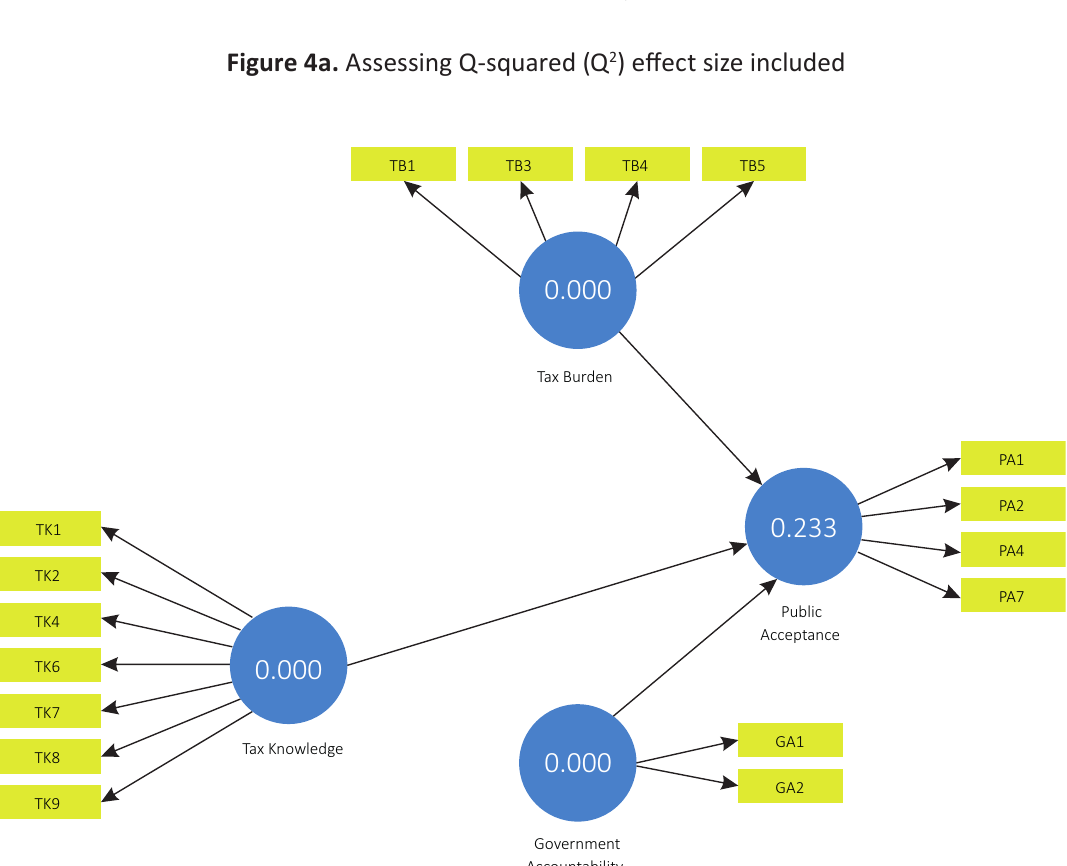
Figure 4b. Assessing Q-squared (Q 2 ) effect size Тax fairness excluded (blindfolding technique)